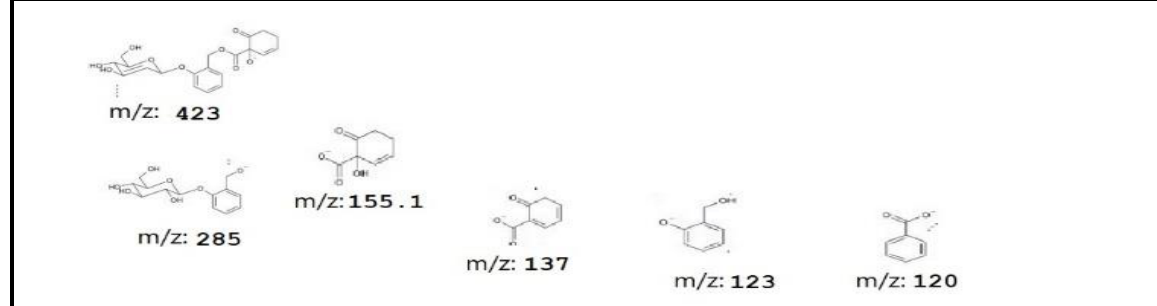
Figure 18. Fragmentation pathway of